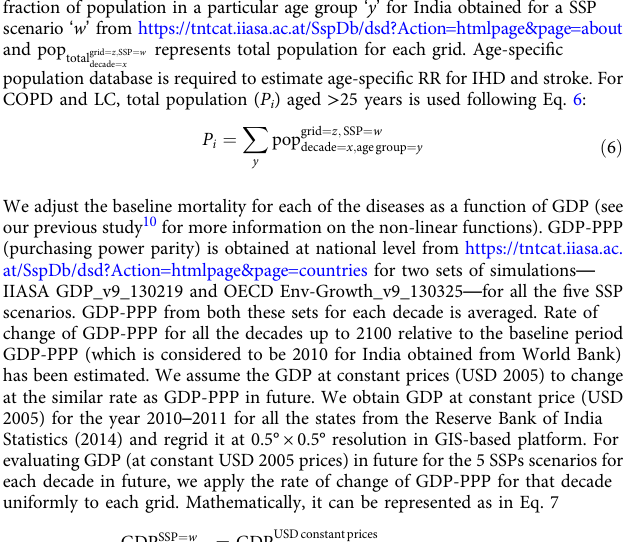
and 4 in Methods section). PM 2 : 5 sat (bl) period (2001 – 2005). PM 2 : 5 model 1 in the Methods section). PM 2 : 5 model